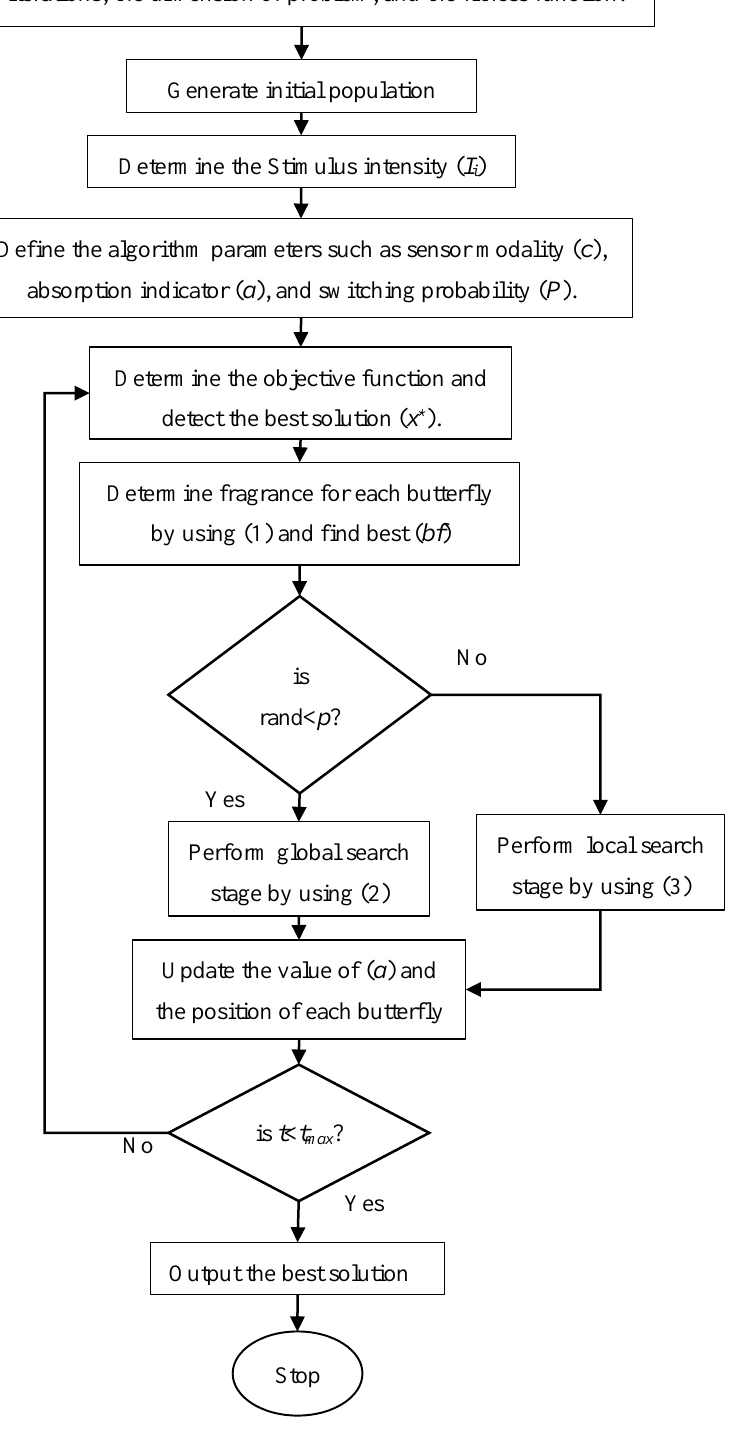
Figure 1. The flowchart of the BOA.